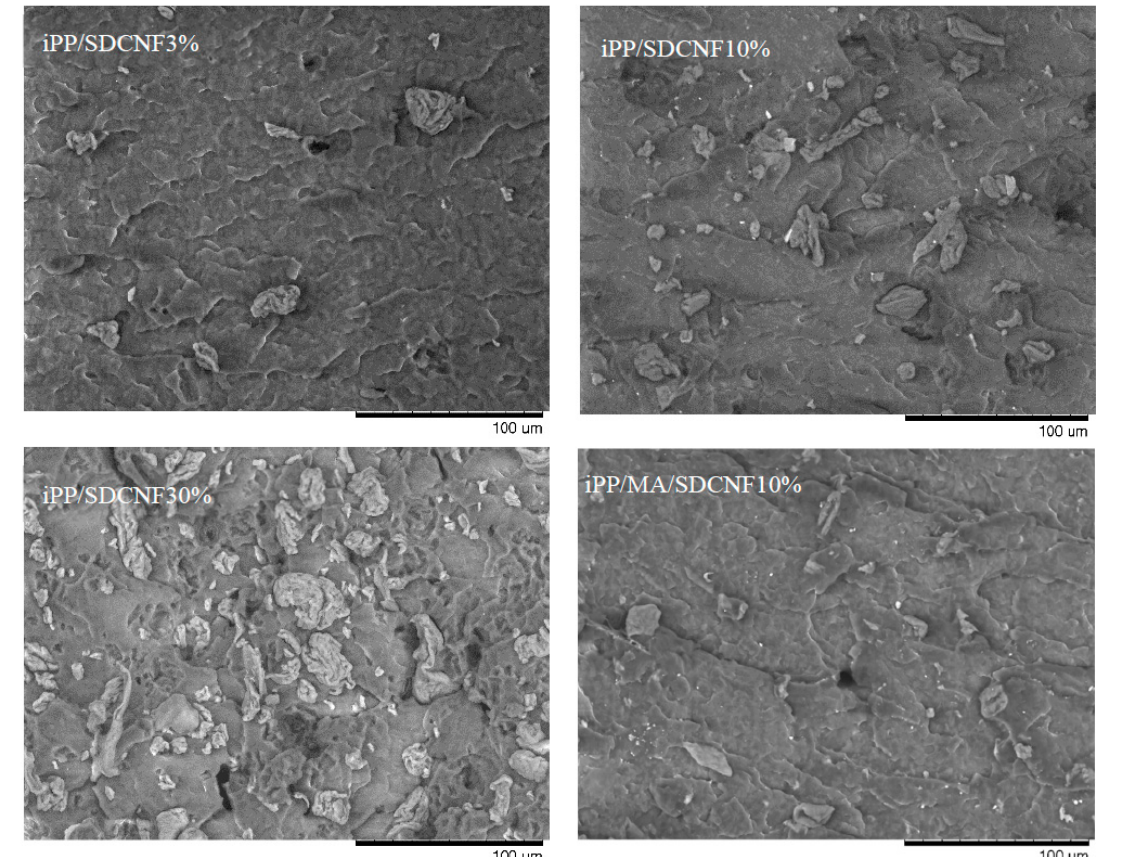
Figure 6. SEM micrographs showing the distribution of SDCNF within iPP.